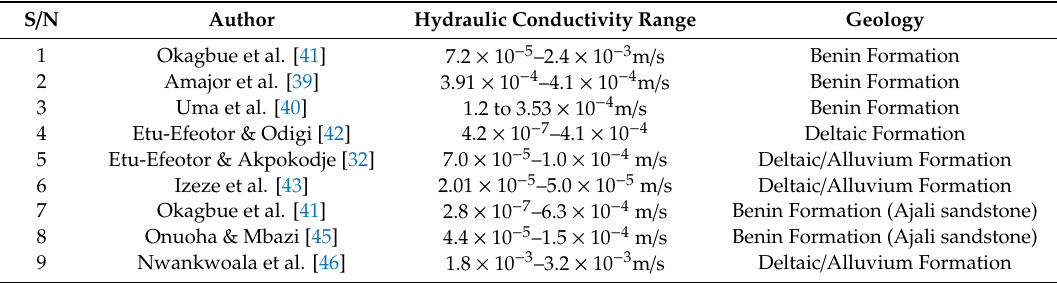
Table 3. Hydraulic conductivity values from di ff erent authors across the study